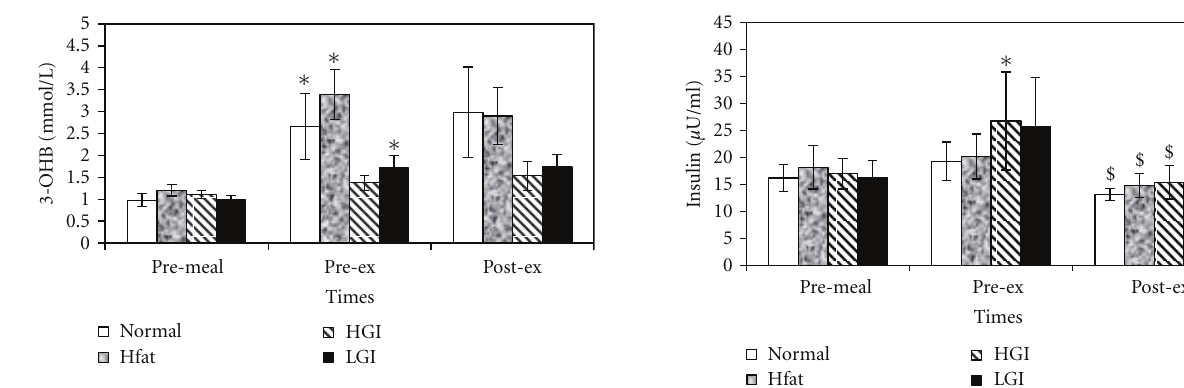
Figure 5: Mean ( ± SE) plasma insulin concentrations at pre-meal, pre-exercise and, post-exercise for four trials. ∗ indicates significant with resting values and $ indicates significant di ff erence with postprandial